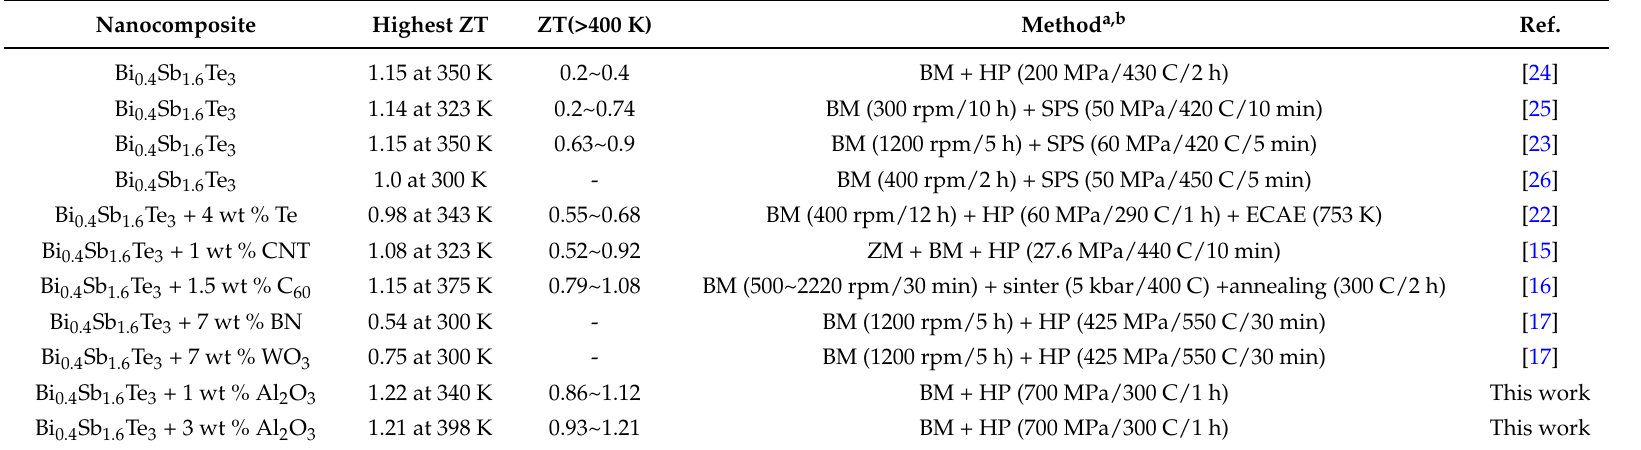
Table 1. TE properties and preparation methods of typical Bi 0.4 Sb 1.6 Te 3 -based